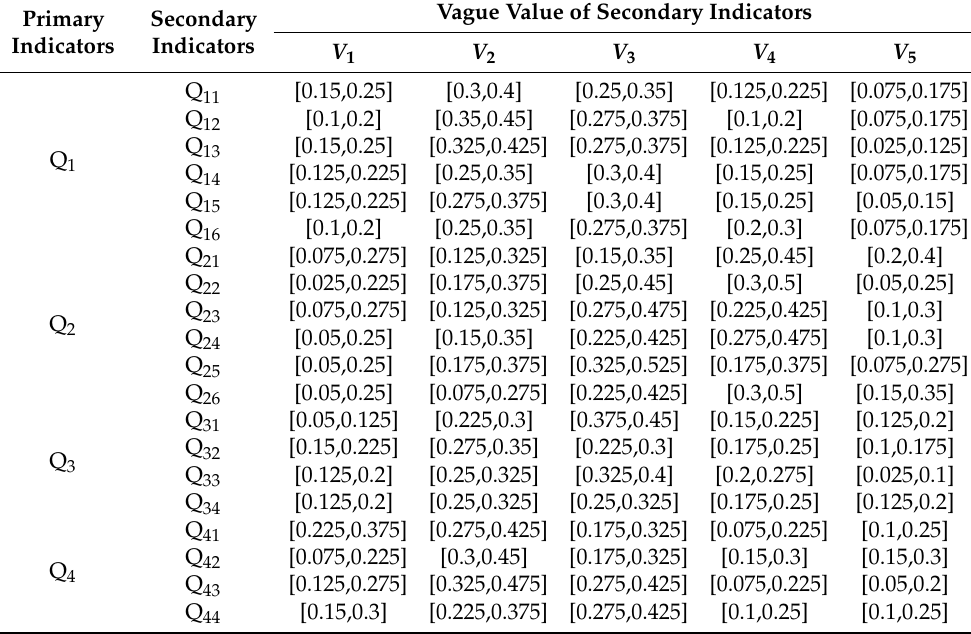
Table 4. Vague set evaluation matrix of YC evaluation index by expert